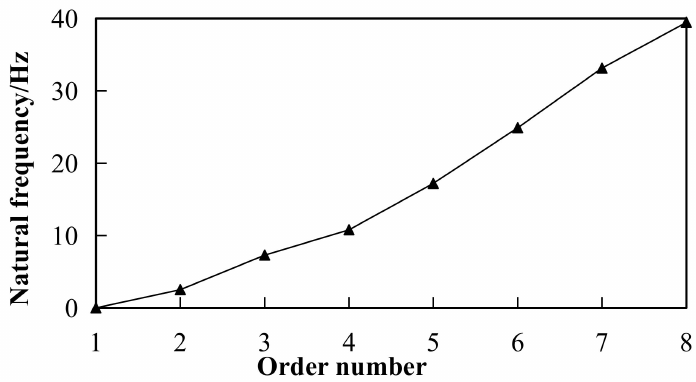
Figure 11. Natural frequency of the slope according to modal analysis by using FEM.